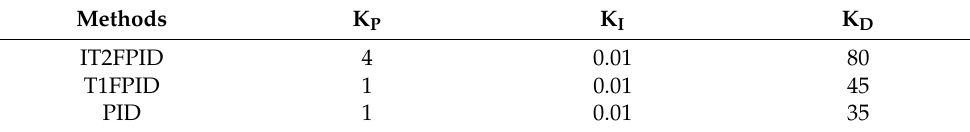
Table 6. The parameters of the IT2FPID, PID, and T1FPID